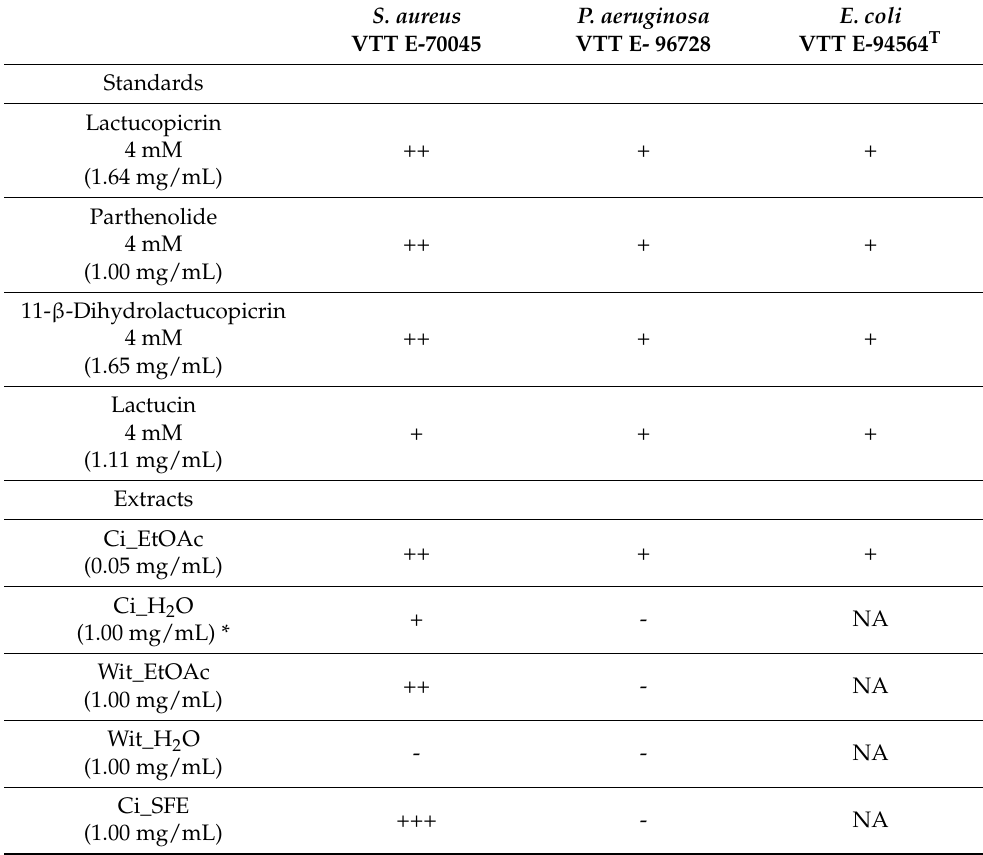
Table 2. Antimicrobial activity of selected pure sesquiterpene lactones and chicory extracts dissolved in